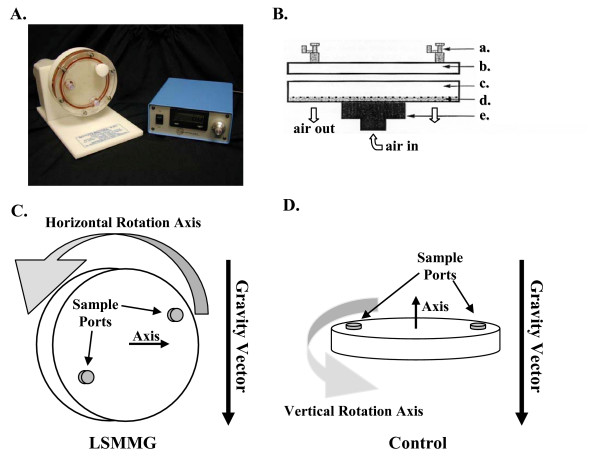
(A) Image of the High Aspect Rotating Vessel (HARV) attached to the rotating/aerating platform and controller (reproduced with permission from Synthecon Inc., Houston, TX). (B) Diagram of the HARV bioreactor vessel with samples ports (a.), front plate (b), 50 ml culture chamber (c), gas permeable membrane (d), and rotator hub base (e) indicated. (C) Low-shear modeled microgravity and (D) control orientations of HARV bioreactors employed for culture growth in these experiments. All cultures were grown at 37°C and HARV rotation was 25 rpm.